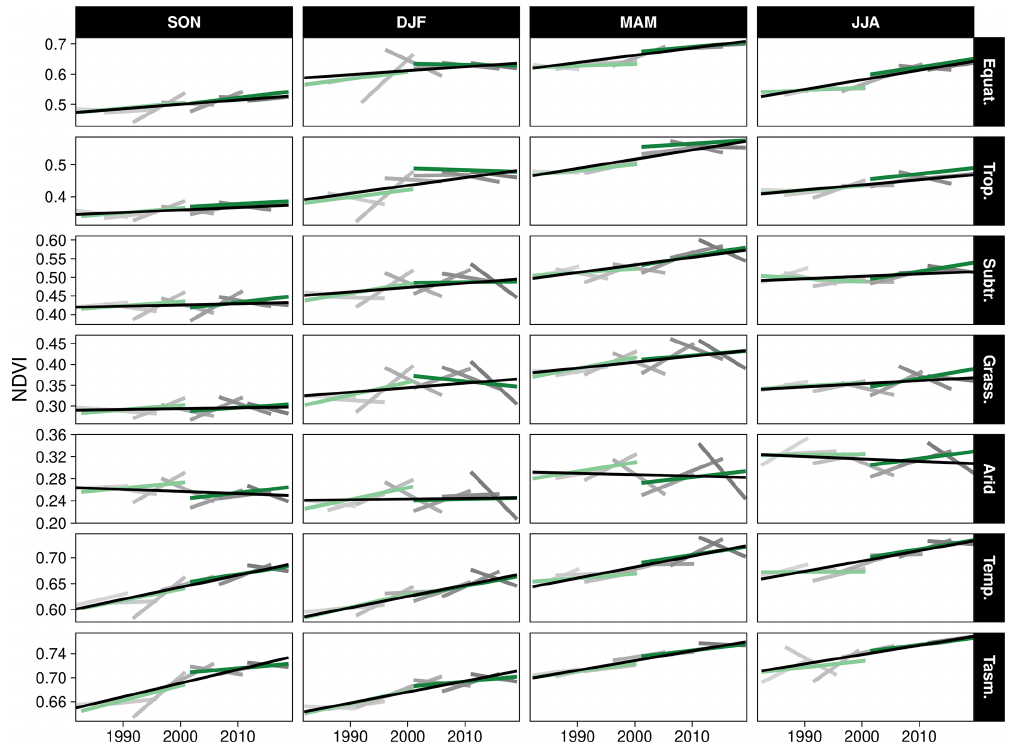
Figure 4. Variability in linear trends over varying time periods by season and climate zone. The black line represents the overall 1982– 2019 trend, the light-green line represents the calibrated 1982–2000 AVHRR, and the green line represents the 2001–2019 MODIS. Gray colors indicate linear trends from overlapping 10-year time intervals. The boundaries of the climate zones are shown in Fig. 2b. Note: climate zone abbreviations correspond to Equatorial (Equat.), Tropical (Trop.), Subtropical (Subtr.), Grassland (Grass.), Temperate (Temp.), and Temperate Tasmania (Tasm.). Season abbreviations correspond to September–October (SON), December–February (DJF), March–May (MAM), and July–August